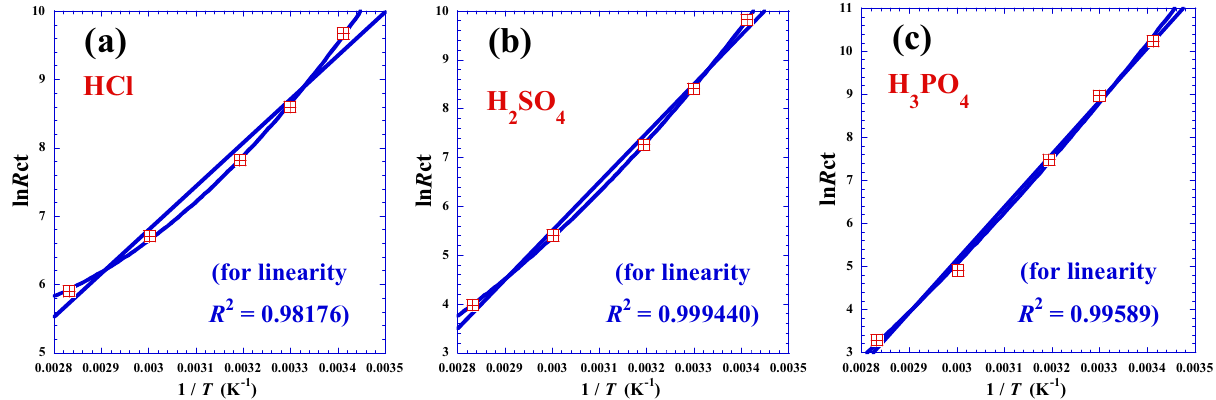
Figure 1. Variation of the logarithm of charge transfer resistance (ln R ct ) as a function of the inverse of the reciprocal temperature (1/ T ) related to the hydrochloric acid (HCl), the sulfuric acid (H 2 SO 4 ) and the phosphoric acid (H 3 PO 4 ) for the systems at the temperature range: 20–80 °C; (Table 1). Straight lines: linear regression (Eq. 2). Curved lines: nonlinear regression (Eq. 4) with second degree of polynomial.